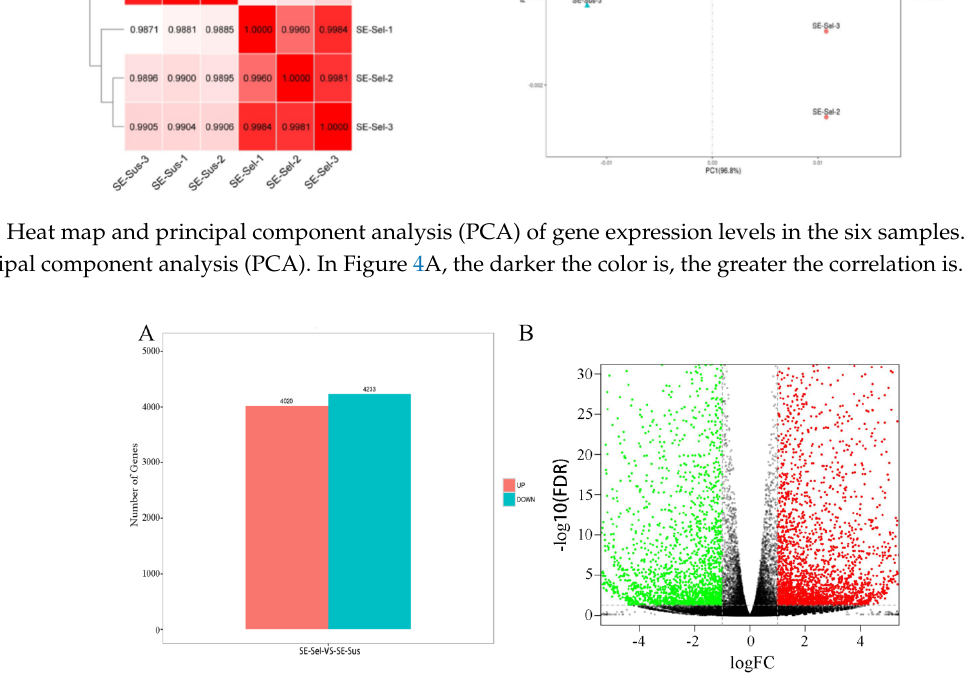
Figure 4. The statistical maps and volcano plot of DEGs among SE-Sel vs. SE-Sus. ( A ) The statistical maps; ( B ) The volcano plot. In Figure 5B, color-scaled represents log 2 (fold change) values for resistant lines, red indicates upregulated genes, green indicates dow-regulated genes, and black indicates genes with no difference in expression.